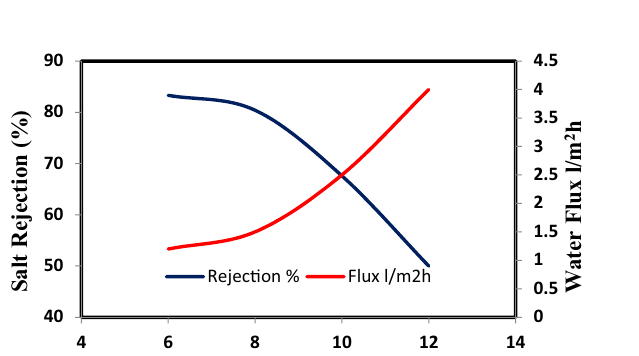
Figure 12. Salt rejection and water flux versus feed pressure of CA-RO membrane with 35% NRCA